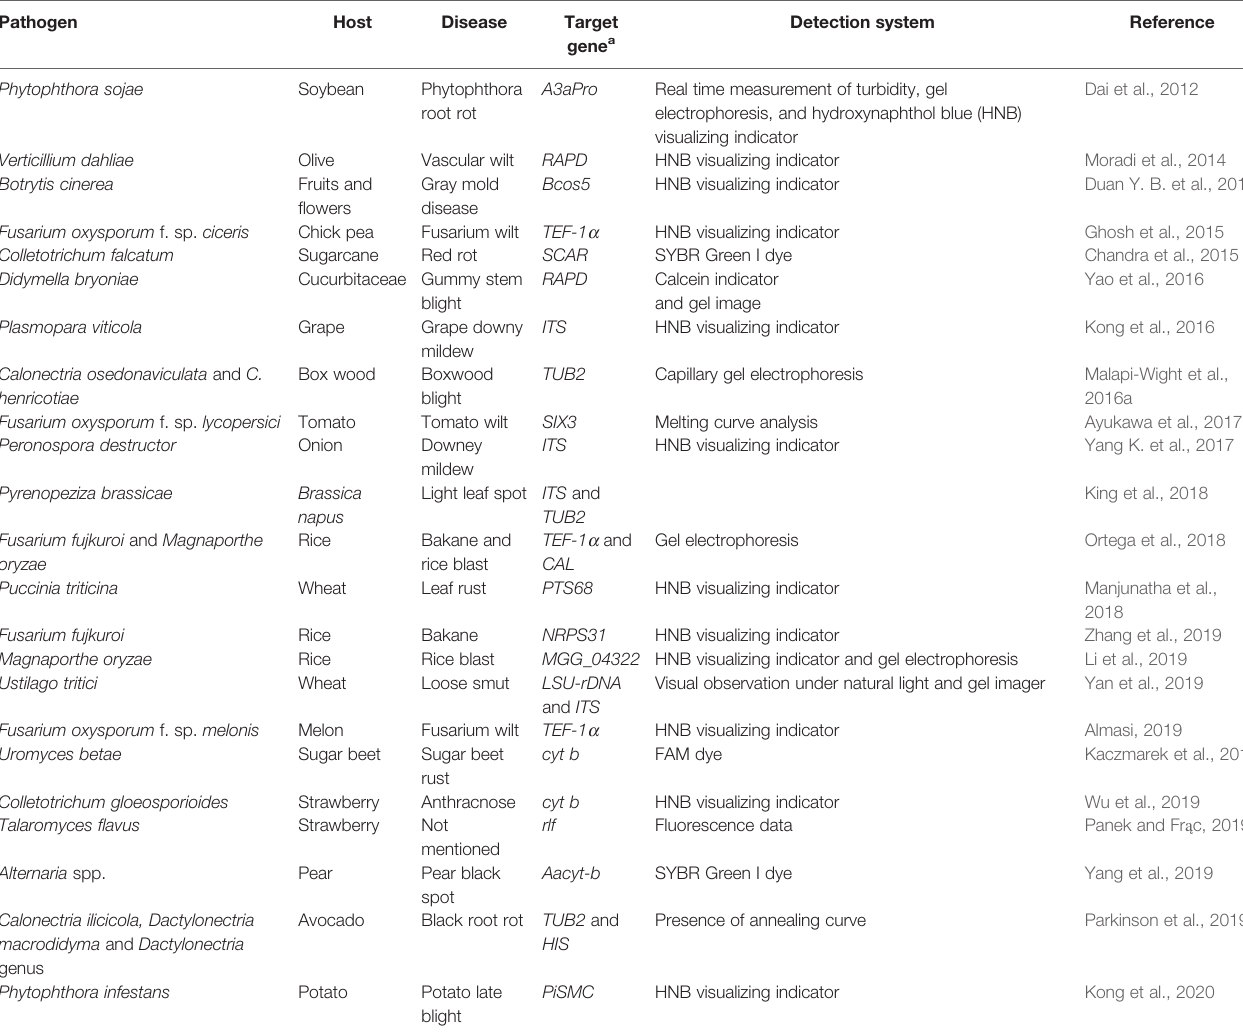
TABLE 2 | LAMP based molecular diagnosis of fungal pathogens in various